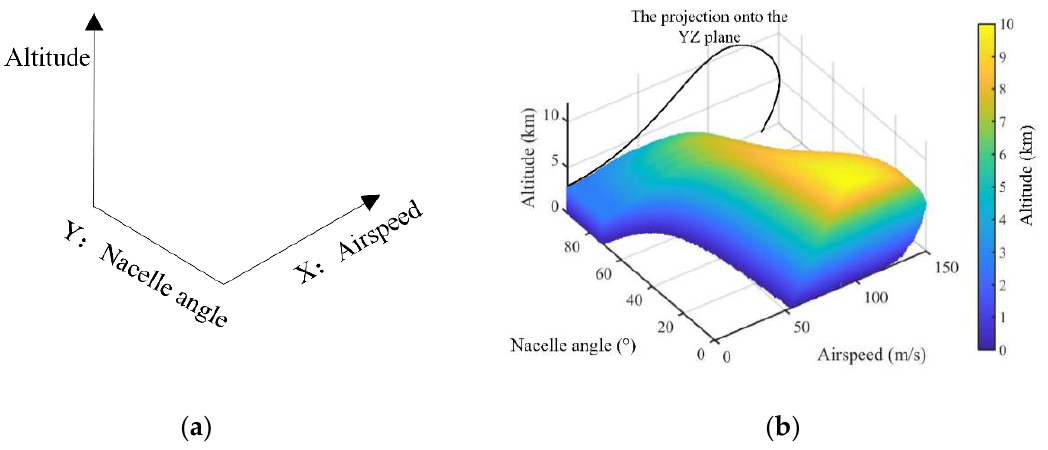
Figure 3. ( a ) Coordinates definitions of the 3D flight envelope; and ( b ) an example of the 3D flight envelope (XV-15).